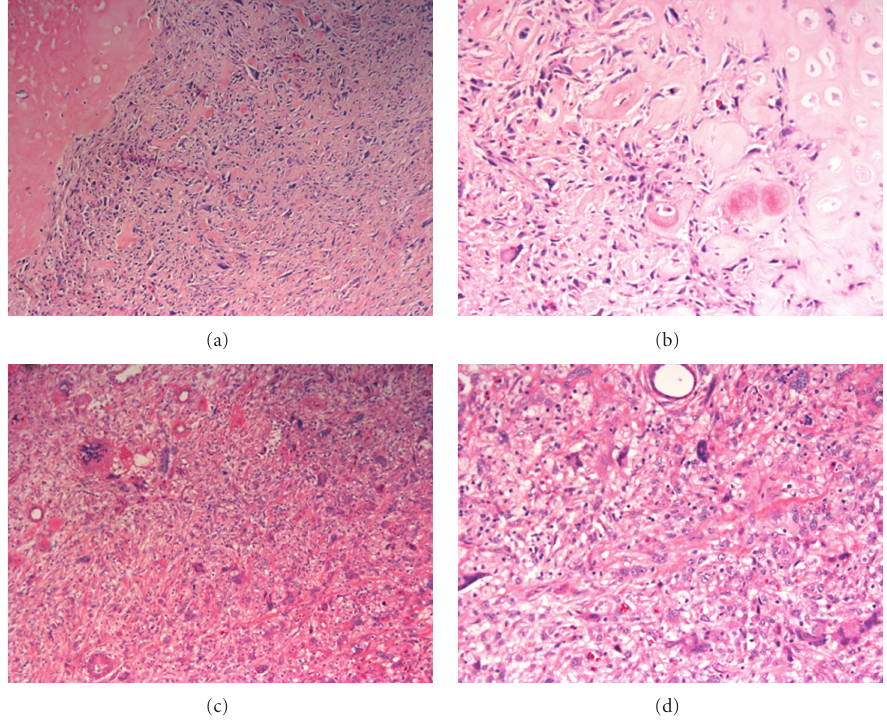
Figure 1: (a) The pelvic resection specimen of dedi ff erentiated chondrosarcoma demonstrated low-grade component (left) abruptly jux- taposed to high-grade dedi ff erentiated component (right) (10x, H&E). (b) Focal osteoid formation was present within the dedi ff erentiated component (20x, H&E). (c) The lung metastases consisted entirely of the dedi ff erentiated component of the primary tumor (10x, H&E). (d) Focal osteoid formation was noted within the metastatic tumor (20x,